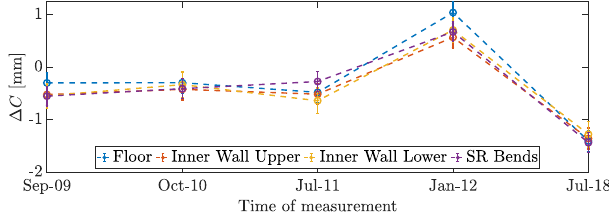
FIG. 7. Long term circumference measurement at different monuments inside the current ALS tunnel. Plotted is the circum- ference change with respect to the previous measurement as measured at the floor (blue), the inner wall at 2m (red) and near the ground (yellow) and via fiducial points on the ALS dipole magnets (purple) over 9 years of operation.